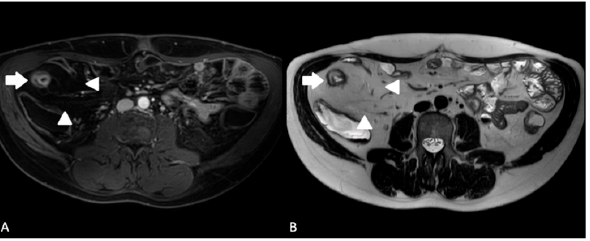
Figure 3. A 24 ‐ year ‐ old male with ileal CD. ( A ) Axial T1 ‐ weighted fat ‐ saturated post ‐ contrast se ‐ quence demonstrating terminal ileal wall thickening and hyperenhancement (arrow) with creeping fat (arrowheads); ( B ) axial T2 ‐ weighted sequence demonstrating terminal ileal wall thickening and